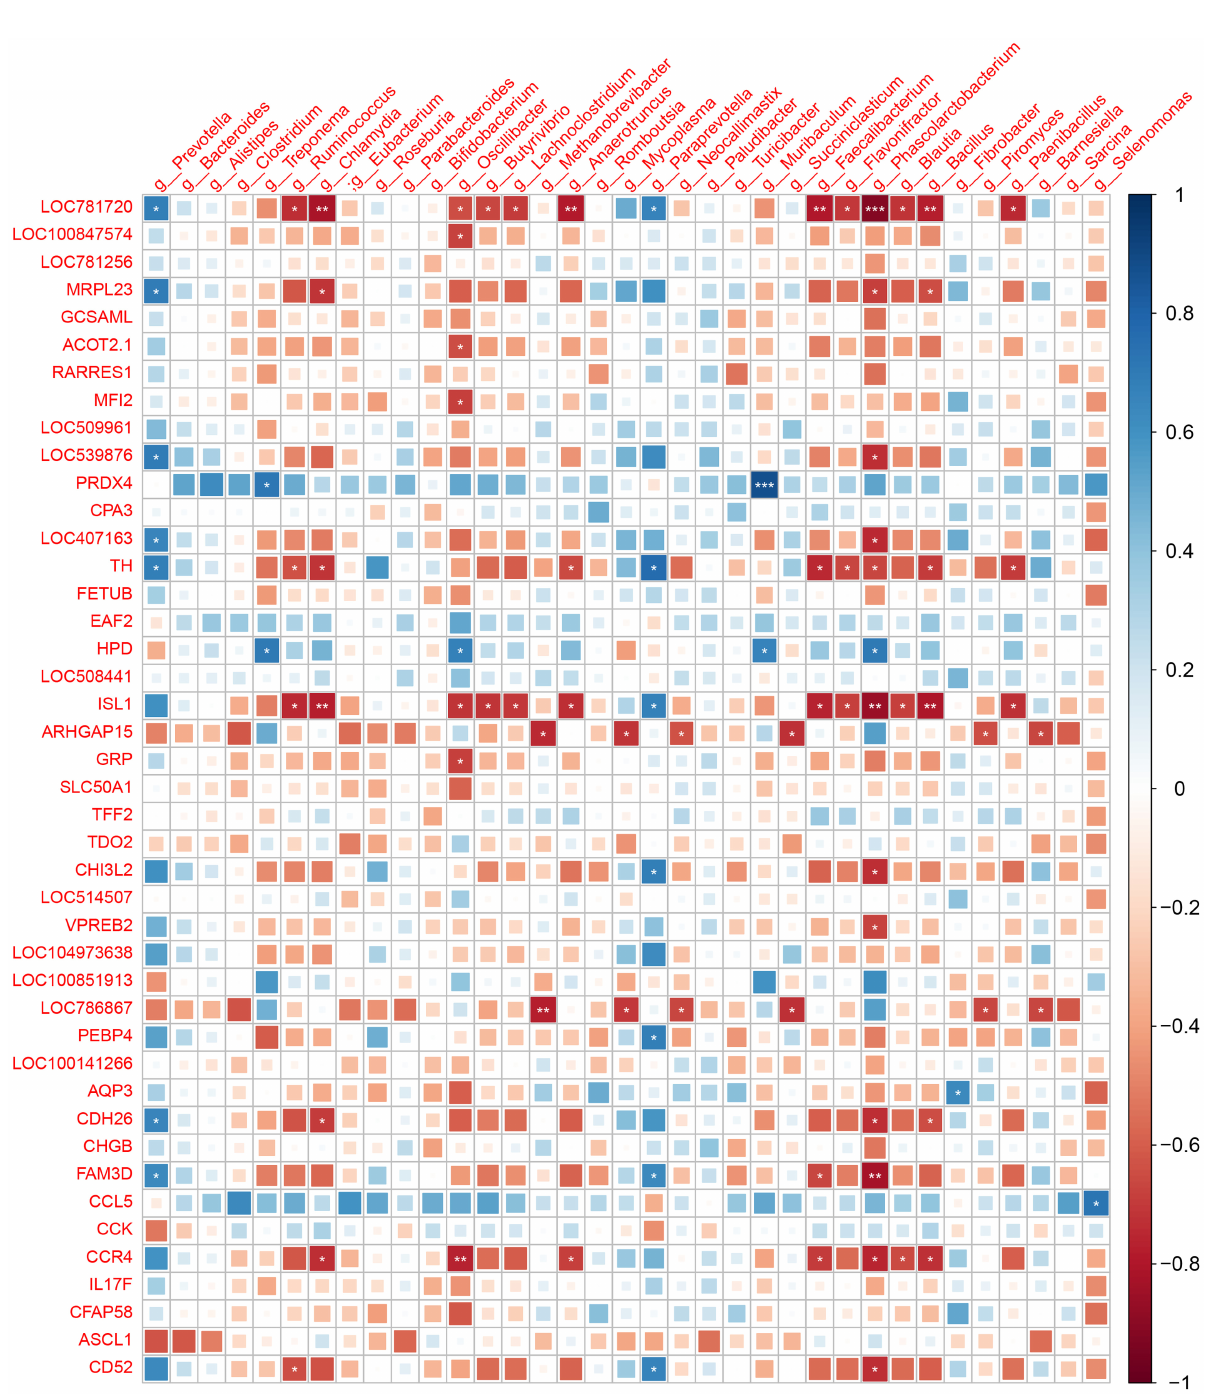
Figure 4. Correlation analysis of hosts’ differentially expressed genes and microbiota. The color and size of the square indicate the degree of correlation; the asterisk indicates the significance of the correlation (** indicates P < 0.01, * indicates P < 0.05); blue indicates positive correlation; red indicates negative correlation.